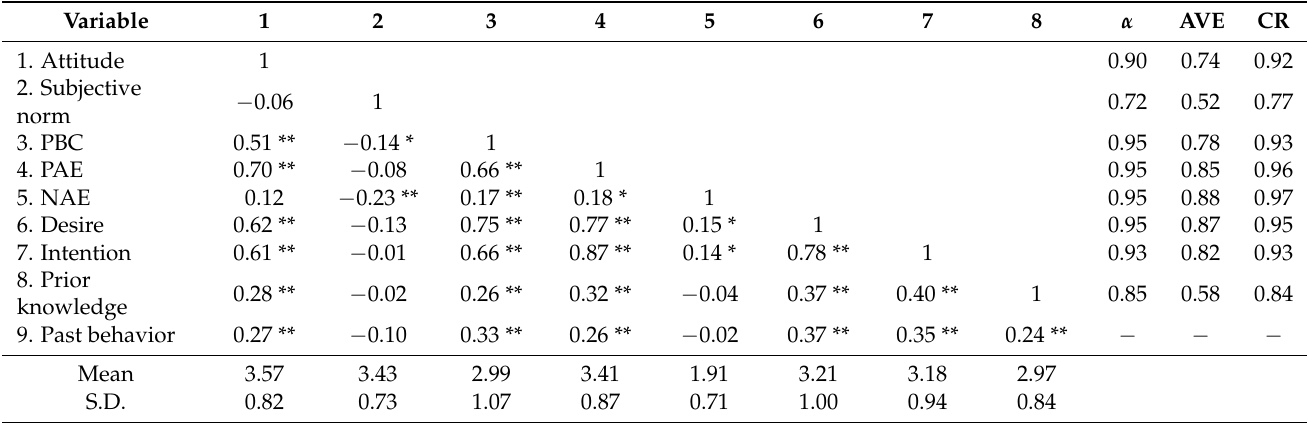
Table 1. Correlations, reliability and validity.